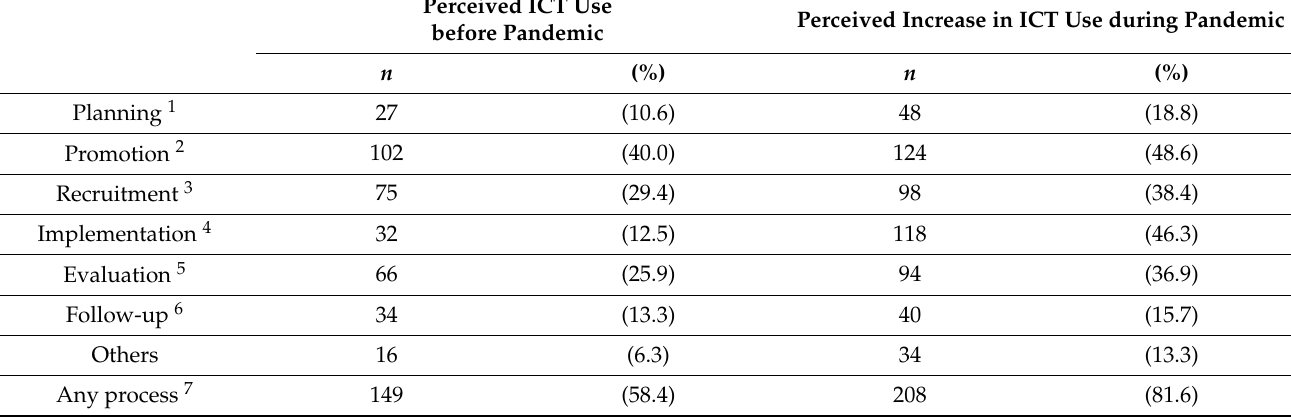
Table 4. Perceived ICT use in work processes before the COVID-19 pandemic and perceived increase in ICT use in work processes during the COVID-19 pandemic ( n = 255).